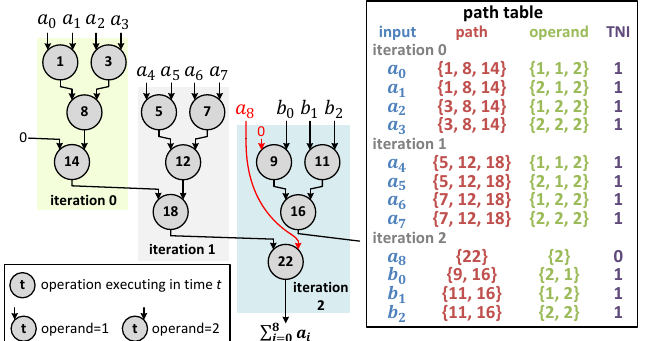
a i needs to be i = 0